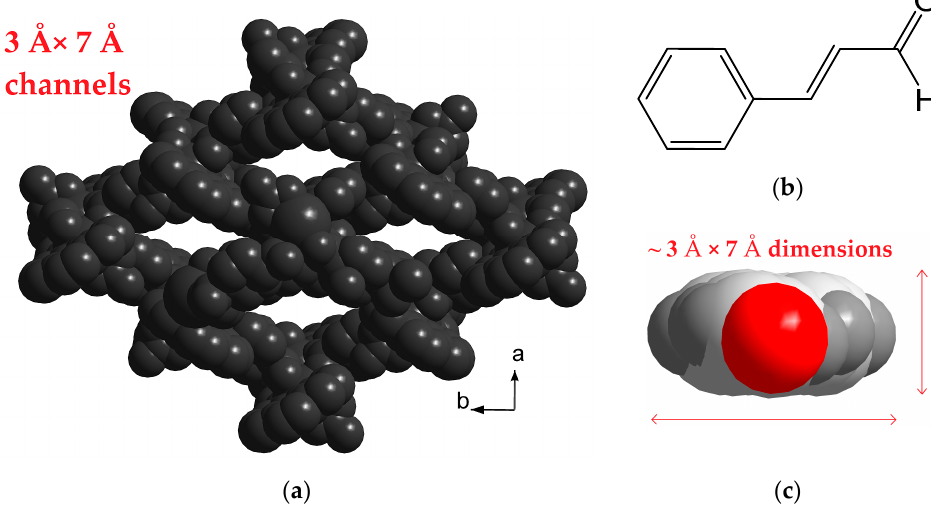
Figure 5. Three-dimensional (3D) packing of 3 in van der Waals spheres, viewed along the c -axis ( a ). Structural formula of cinnamal ( b ). Spatial representation of cinnamal molecule ( c ).